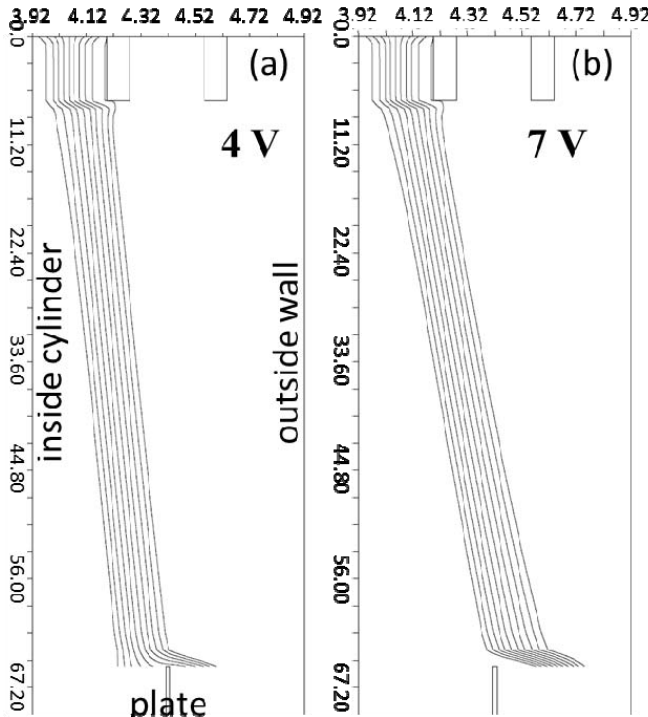
Fig. 5 Calculated 300 nm-particle trajectories in the apparatus at the flow rate of 300 mL/min and the applied voltage of: